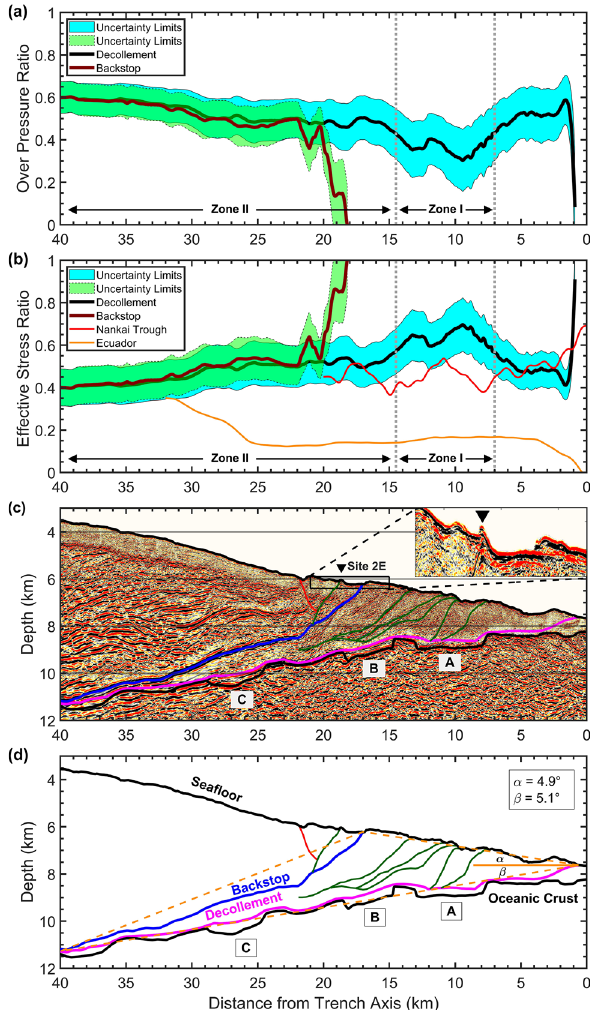
Figure 4. Fluid drainage, stress state, and fault strength. ( a ) Pore-fluid overpressure ratio for decollement (black line) and backstop interface (maroon line) shows that backstop interface is well drained within a distance of 22–18 km due to the active drainage system through a reverse fault reaching to the seafloor at site 2E. Two zones are identified across the decollement, Zone I has a better drainage for the fluid expulsion but Zone II has a poor drainage condition with fluids mostly maintained in the pore spaces. ( b ) Effective stress ratio along the decollement (black line), backstop interface (maroon line), Nankai Trough 11 (red line), and Southern Ecuador 12 (orange line). Larger values of effective stress ratio imply on stronger fault coupling while lower values indicate that fault is mechanically weak and prone to slip. For Japan Trench, backstop interface is stronger than decollement within 22–18 km distance and is not a preferable path for fault slip to the seafloor. The effective stress ratio of decollement is lower than 1.0 along the whole profile, despite the higher values in Zone I, which result in frictional instability and rupture propagation to the seafloor. ( c ) Interpreted reverse faults (dark green lines) and a normal fault (red line) on the RTM image. ( d ) Schematic drawing of the wedge zone and seismic interpretations. A triangle shown by dashed orange lines is used to define surface slope angle α and basal dip